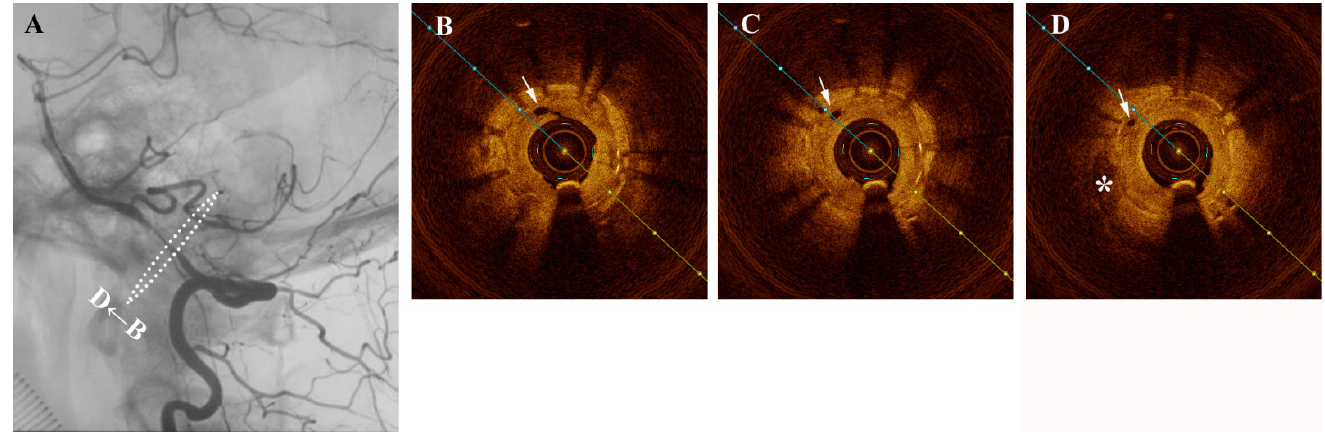
Figure 1. A middle-aged female presented one year after intracranial stenting for severe left intradural segment vertebro- basilar stenosis with recurrent vertigo. Digital subtraction angiography (DSA) confirmed severe in-stent restenosis and same-session optical coherence tomography (OCT) with an Ilumien Optis probe (St. Jude Medical, St. Paul, MN, USA) showed neovascularization-related neointimal hyperplasia (Figure 1). Figure 1 ( A ) Angiography confirming severe intra- cranial in-stent restenosis of the left intradural vertebral artery segment. Figure 1 ( B – D ) Pre-intervention cross-sectional optical coherence tomography (OCT) shows hypertrophic intima and hyporeflective microchannels (white arrow) originating directly from the lumen and penetrating contiguously towards the plaque (*). These are seen as hyporeflectile microchannels originating directly from the lumen, which penetrate contiguously towards irregular plaque and hyperplastic intimomedial complex. Neovascularization plays a role in intracranial atherosclerosis by providing trophic factors to plaque [1]. Such neovasculature is susceptible to intra-plaque hemorrhage and also importantly is a critical factor in the propagation of intimal hyperplasia following stenting [2]. Intracranial neovasculature cannot be resolved in-vivo by traditional imaging methods. In 2011, Mathews et al. performed OCT in the cavernous and the petrous segments of internal carotid artery, which used time-domain OCT assembled in a laboratory rather than a commercial product [3]. Although a small number of cases were enrolled, the result suggested that OCT examination of intracranial arteries was feasible. Until now, there have been numerous preliminary attempts at intracranial OCT use, but visualization of intracranial neovasculature has heretofore not been reported in a living patient. With the approximately 40 micron resolution afforded by OCT, an extremely rare and vivid look at the mechanisms behind plaque nutrition and neointimal hyperplasia of the intracranial vertebral artery is possible [4]. The in-stent stenosis was treated a Sequent Neo paclitaxel-coated balloon (B.Braun, Melsungen, Germany) for intimal hyperplasia inhibition (Figure 2). As plaque and neointimal morphologic characteristics are increasingly recognized as important contributors to disease prognosis and natural history, OCT may stand to inform treatment decisions and assess intimal tearing in the